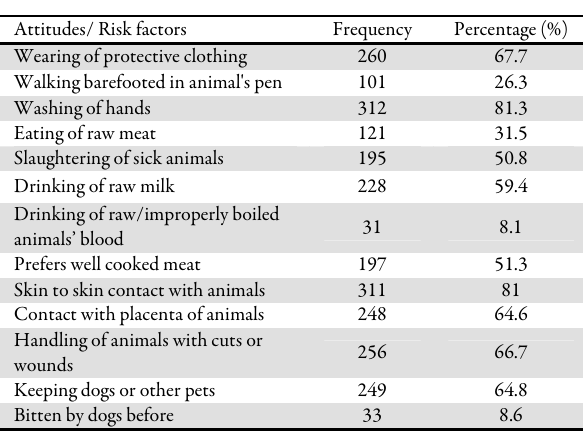
Table 3. Attitudes and risk factors of zoonotic diseases amongst the herdsmen and livestock farmers in the study area